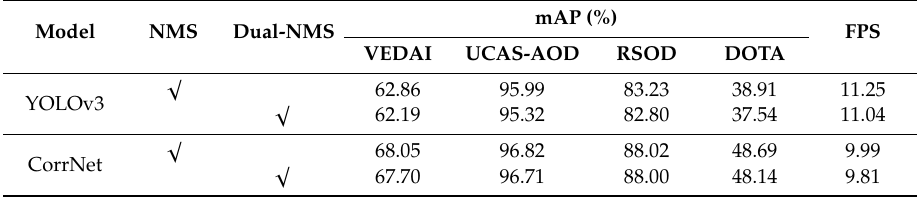
Table 7. The e ff ects of the dual-NMS on the mAP and FPS in di ff erent detection networks.